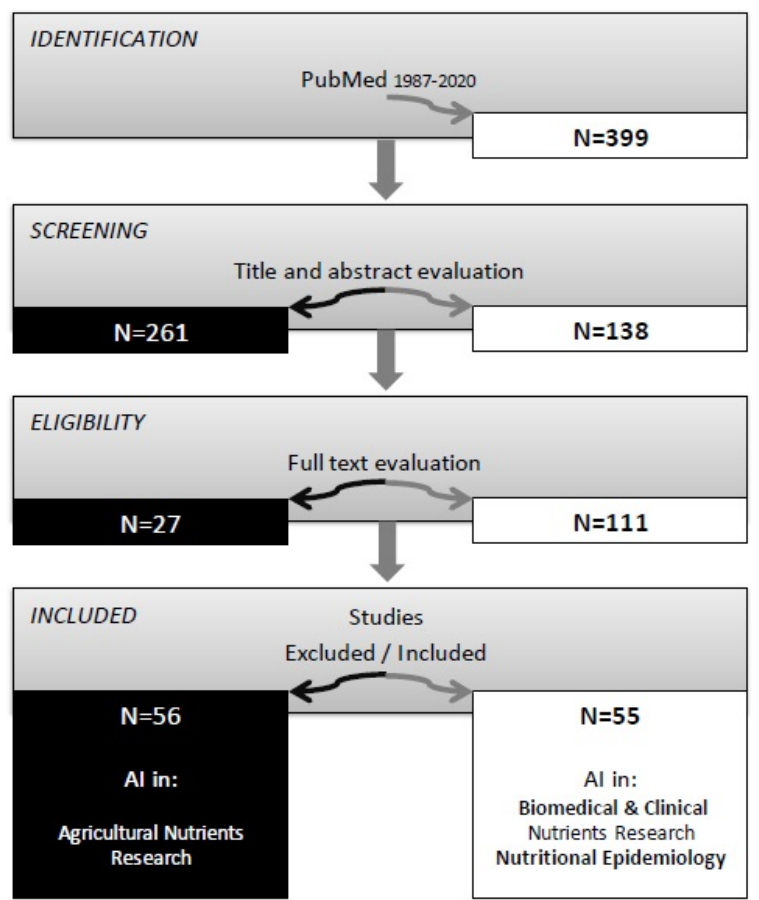
Figure 1. Methodological flowchart of papers reviewed.